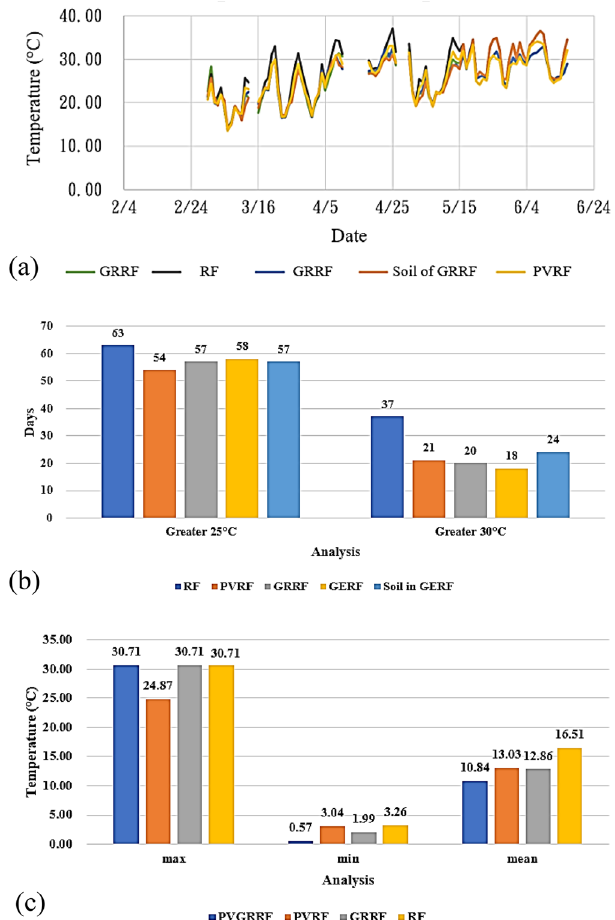
Figure 8. ( a ) Mean daily temperatures, ( b ) number of days with the temperature exceeding 25 °C and 30 °C, and ( c ) temperature changes for each roof type between March 1 and June 16.